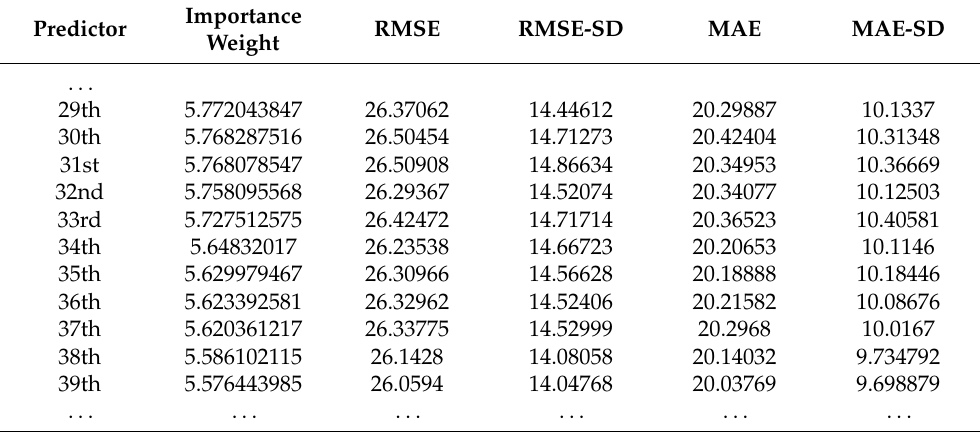
Table 2. RMSE and MAE after the 29th Predictor.